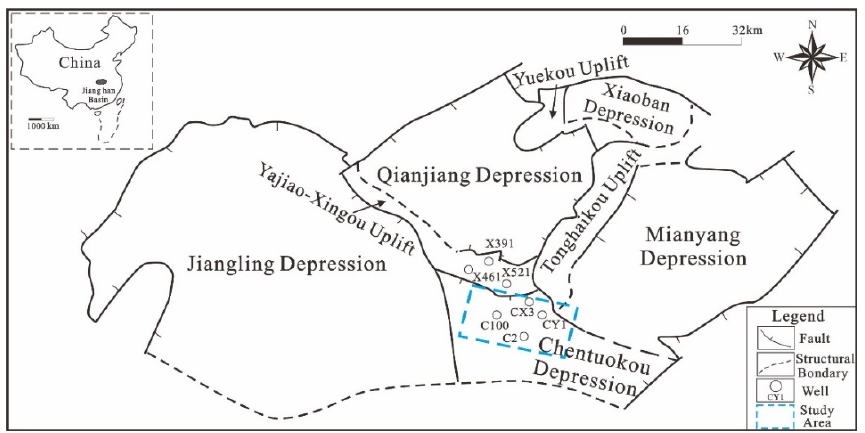
Figure 1. Generalized structural units map of the Jianghan Basin and research area modified from [24,27].